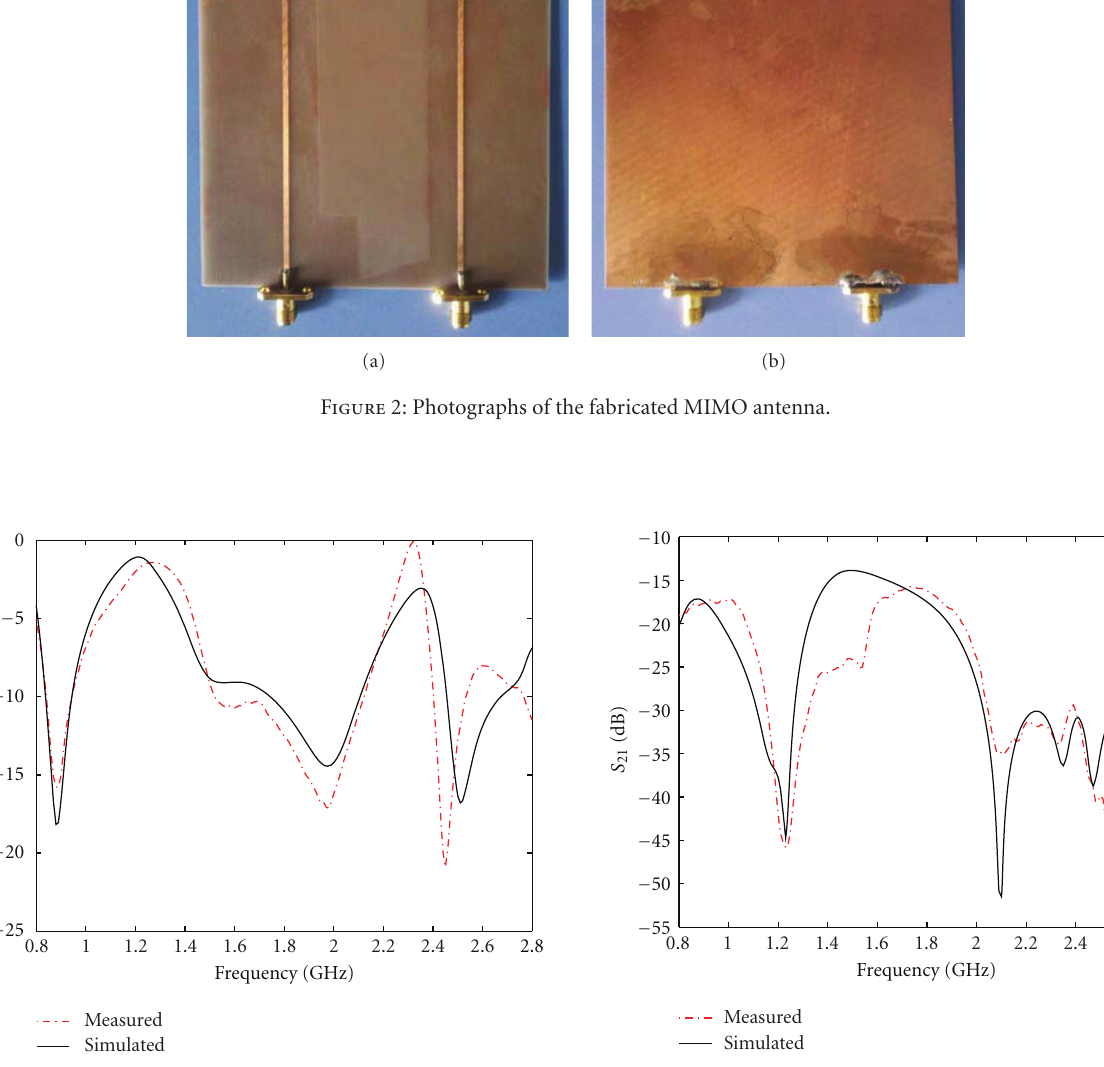
Figure 3: Measured and simulated S 11 of the proposed antenna.